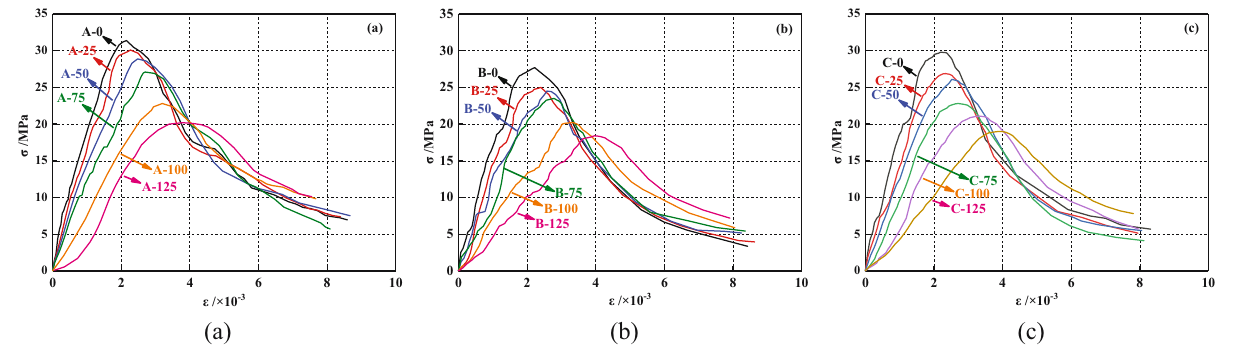
Figure 12: Stress – strain curves before and after freezing and thawing: ( a ) A; ( b ) B; and ( c )